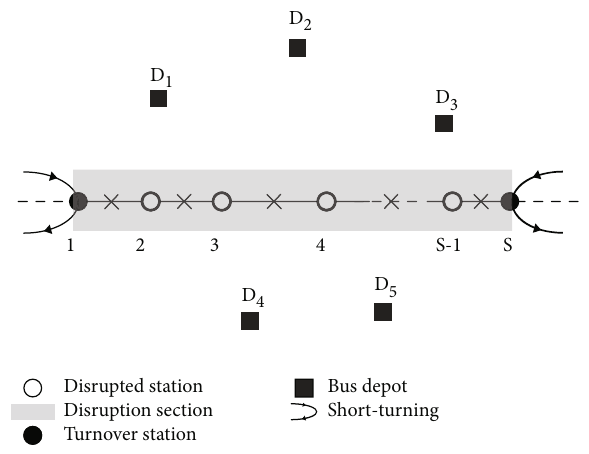
Figure 1: Disruptive section in the URT